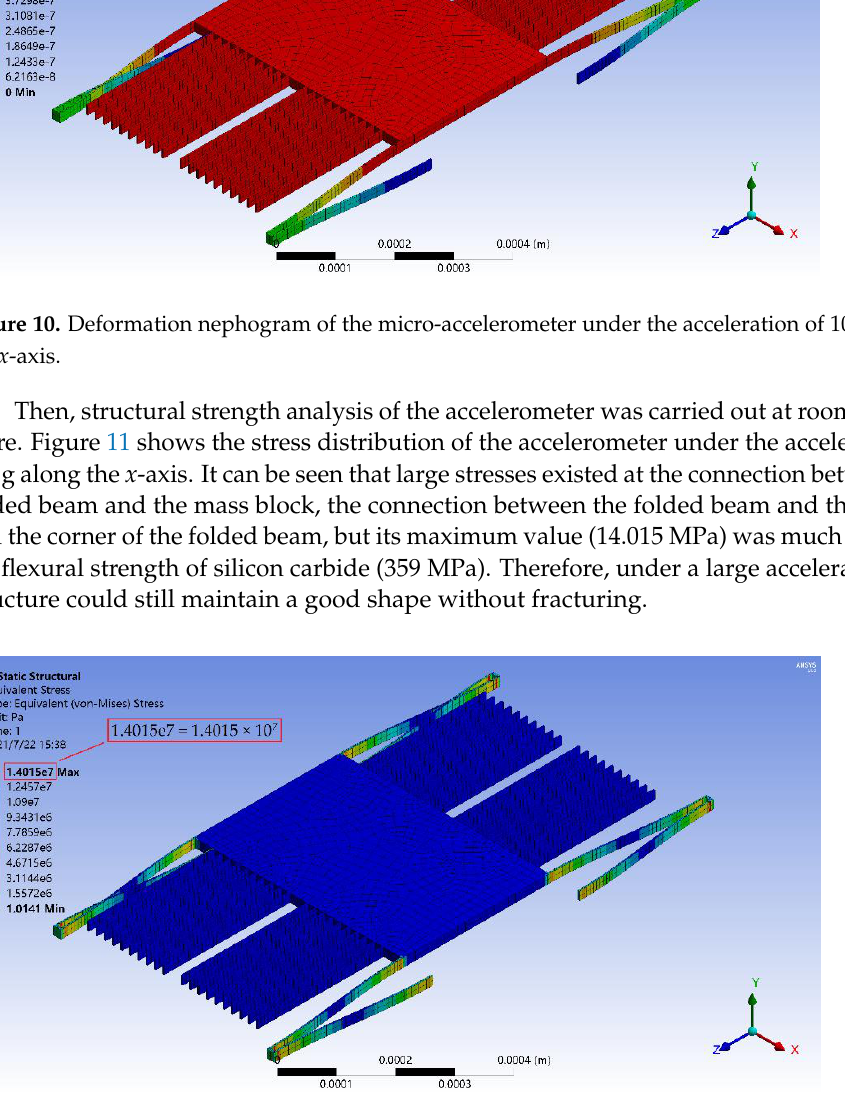
Figure 11. Stress nephogram of the micro-accelerometer under the acceleration of 100 g along the x -axis.